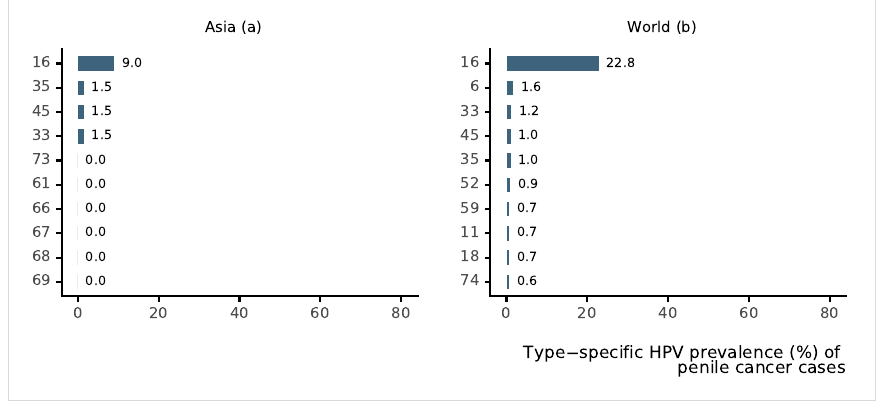
Figure 68: Comparison of the ten most frequent HPV types in cases of penile cancer in Asia and the World